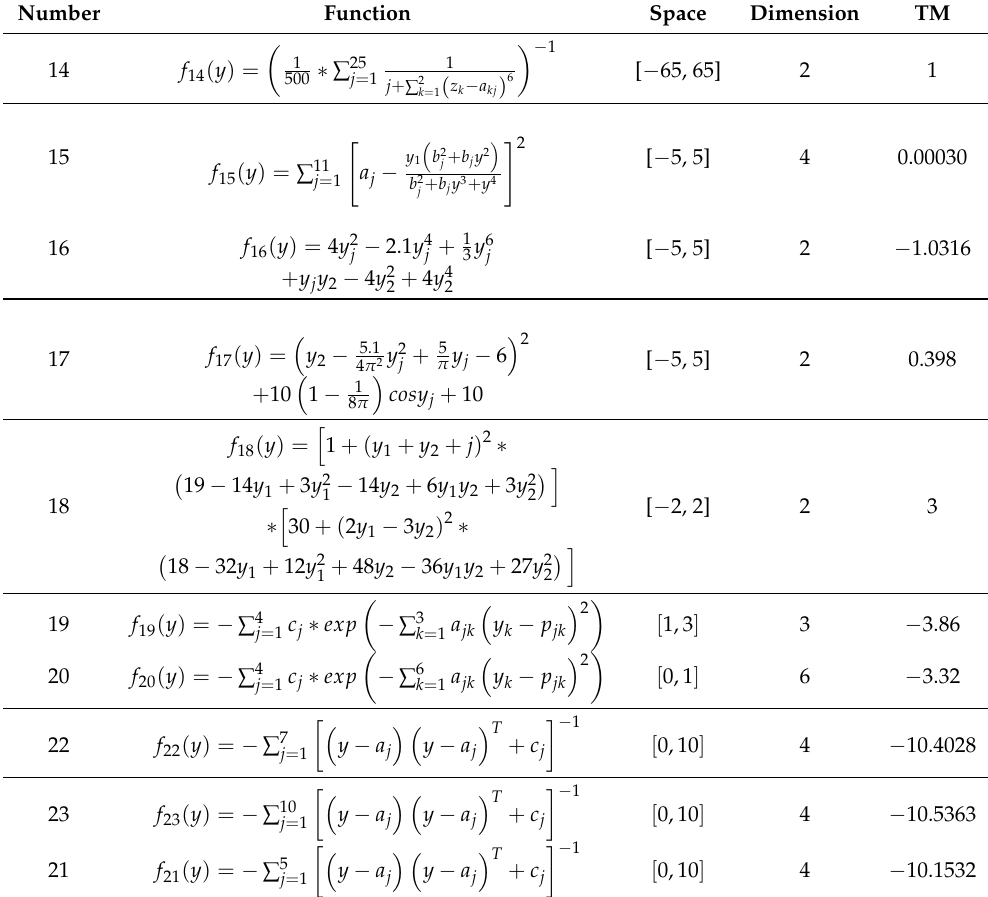
Table 3. Others peak in test function.